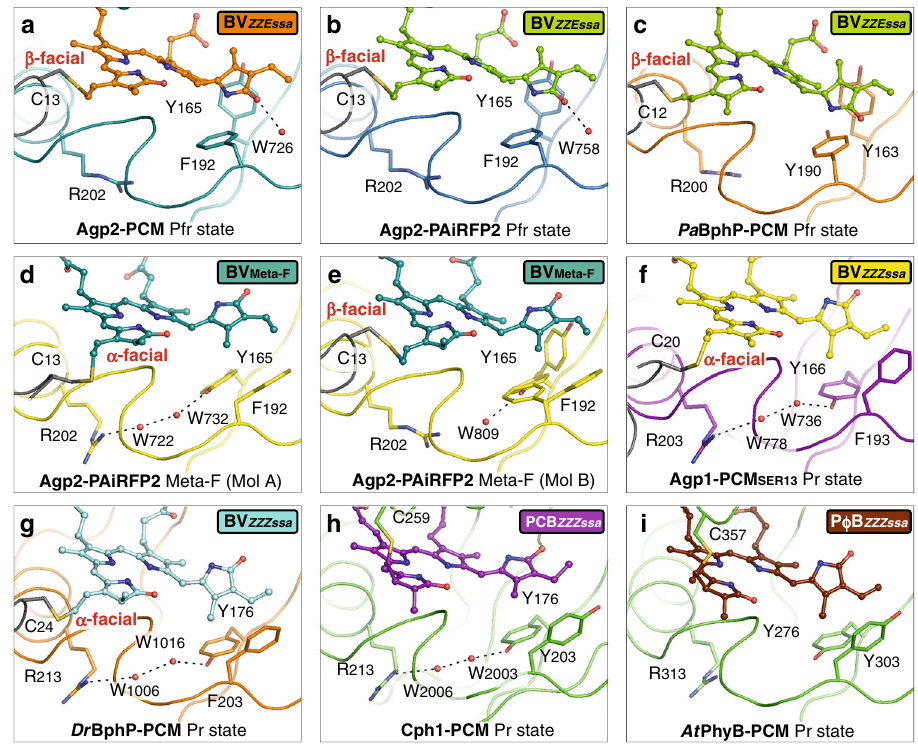
Fig. 7 Structural comparison of various phytochromes in different states of the photocycle. Proteins in ribbon representations, bilin chromophores in ball/ stick representations. Selected conserved amino acids are highlighted as sticks, water molecules are shown as red spheres. In the Pfr state of bathy bacteriophytochromes ( a , wild-type Agp2-PCM and b , Agp2-PAiRFP2; c , Pa BphP-PCM ( P. aeruginosa ; PDB entry 3NHQ 29 )) Tyr165, Phe192 and Arg202 show a conserved conformation. Furthermore, the cysteines are always β -facially bound to BV. In the Meta-F state of Agp2-PAiRFP2, the two monomers (Mol A and B) of the asymmetric unit ( d , e ) show slightly different structures. In Mol A, the N-terminus including Cys13 is free of intermolecular interactions (Fig. 5). After illumination, Mol A reveals the BV isomerization and Cys13 in α -facially bound position accompanied by a conformational shift of the N-terminus and a conformational change of Phe192, Tyr165 and Arg202, together with the formation of a hydrogen bond bridge mediated by two water molecules ( d , Wat722 and Wat732) between Tyr165 and Arg202. In Mol B ( e ), the N-terminus is tightly packed to Mol A (Fig. 5). In the Pr states of prototypical bacterial ( f , Agp1-PCM SER13 of A. fabrum , PDB entry 5HSQ 30 and g , Dr BphP-PCM of D. radiodurans ; e.g. PDB entry 4Q0J 18 ), cyanobacterial ( h , Cph1-PCM of Synchocystis sp.; PDB entry 2VEA 31 ) and plant ( i , At PhyB-PCM of A. thaliana ; PDB entry 4OUR 32 ) phytochromes, the rotameric states of the corresponding amino acids as well as the same two water molecules between the Tyr and Arg residues are similar to Mol A in the Meta-F state of Agp2-PAiRFP2 ( d ). Because of the low resolution (3.4 Å), these water molecules were not resolved in the At PhyB-PCM structure